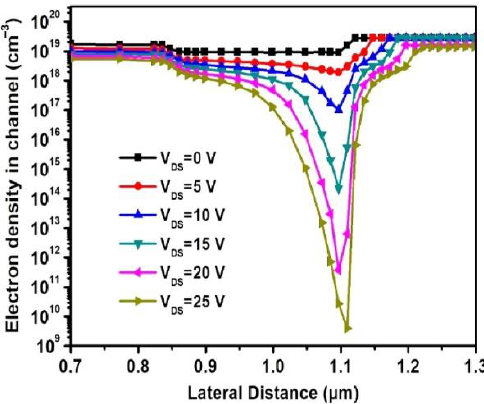
Figure 34. AlGaN/GaN HEMT sheet carrier density along the channel for different drain voltage. Reproduced with permission [160]. Copyright 2021, Elsevier.